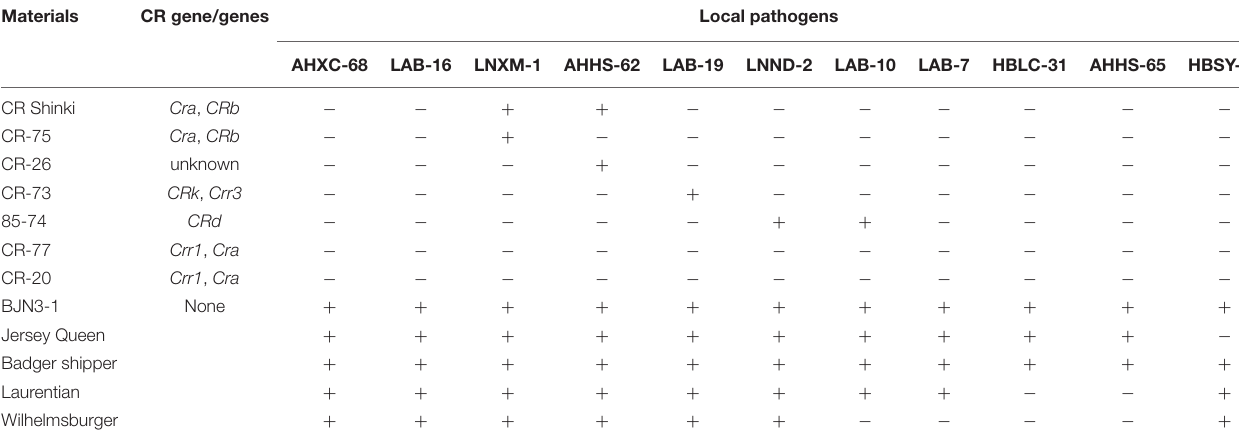
TABLE 1 | Clubroot disease resistance test of Chinese cabbage germplasms and pathotypes identification using Williams’ clubroot differential set. Materials CR gene/genes